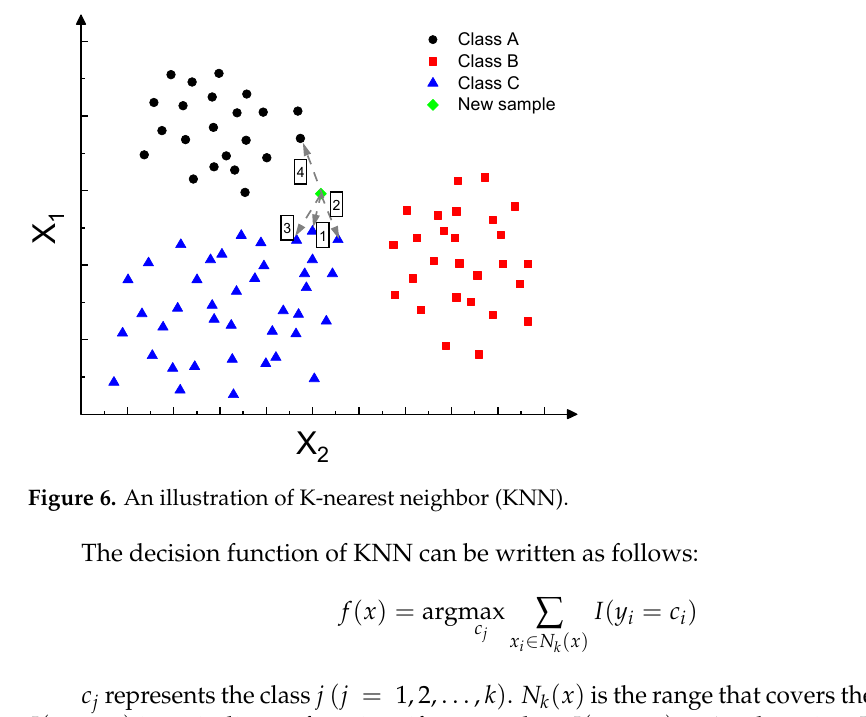
8 of 22 Figure 5. An illustration of the effect of kernel function. 4.2. K-Nearest Neighbor KNN is one of the most concise classification algorithms, and it is also recognized as